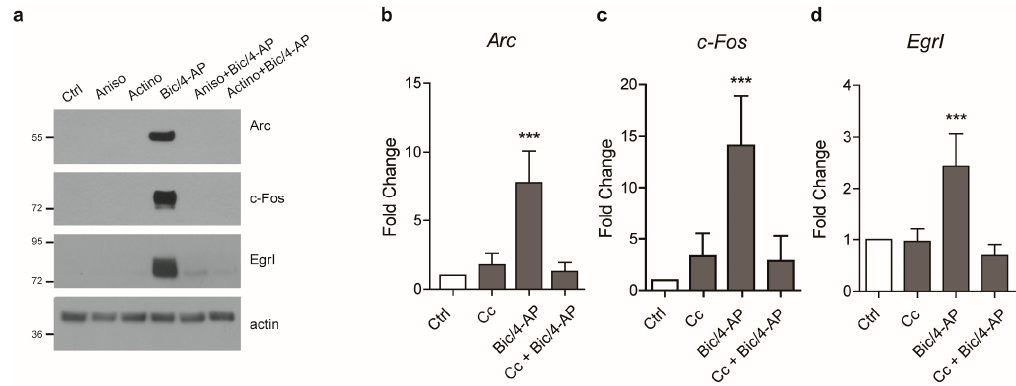
Figure 2. Expression of IEGs required de novo messenger RNA (mRNA) transcription and translation. ( a ) Primary neurons at 15 DIV co-treated with Bic/4-AP (50 µ M/2.5 mM) and the translation inhibitor anisomycin A (Aniso, 25 µ M) or the transcription inhibitor actinomycin D (Actino, 10 µ M) for 2 h were subjected to immunoblotting with anti-Arc, c-Fos, EgrI, and actin antibodies. Results are representative of at least four experiments. Results demonstrate that both translation and transcription are required for the expression of IEGs following synaptic activation (SA). ( b – d ) mRNA levels of Arc , c-Fos , and EgrI were determined by quantitative PCR in primary neurons at 15 DIV treated with Bic/4-AP (50 µ M/2.5mM, 30 min) after 20 min with or without pre-treatment with the AMPK inhibitor Compound C (Cc, 10 µ M). Results show mean ± SD ( n = 4–6). One-way ANOVA followed by Bonferroni’s post-hoc test were used for evaluation of statistical significance, *** p < 0.001.